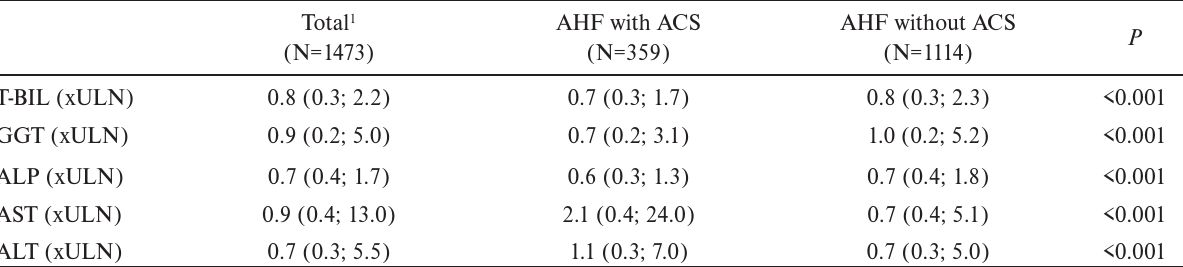
Table 4. Distribution of LFTs elevations according to presence of ACS.